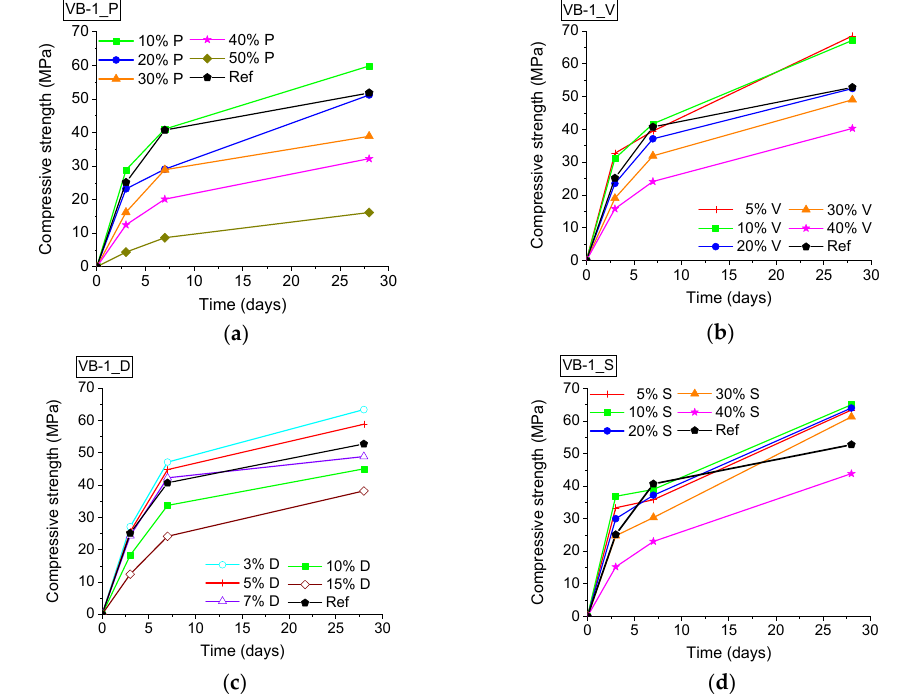
Figure 3. Compressive strength results of the mortars made with the siliceous gravel with moderate reactivity, VB, and four additions mixed in four percentages of 20%, 30%, 40% and 50%: ( a ) natural pozzolan, P; ( b ) siliceous coal fly ash, V; ( c ) silica fume, D; ( d ) blast-furnace slag,